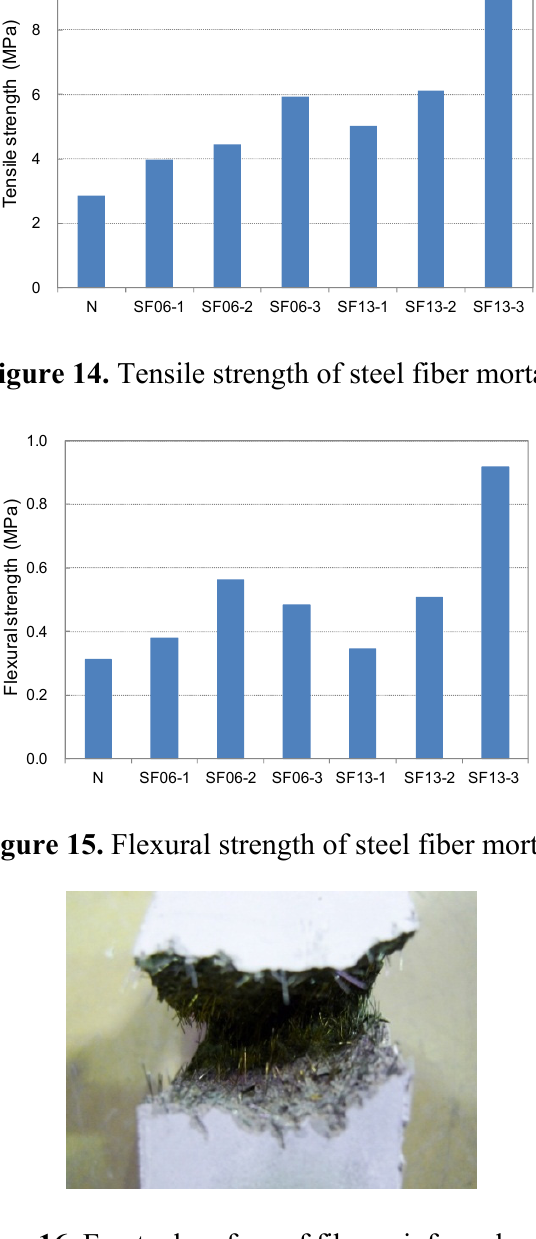
Figure 16. Fractual surface of fiber reinforced